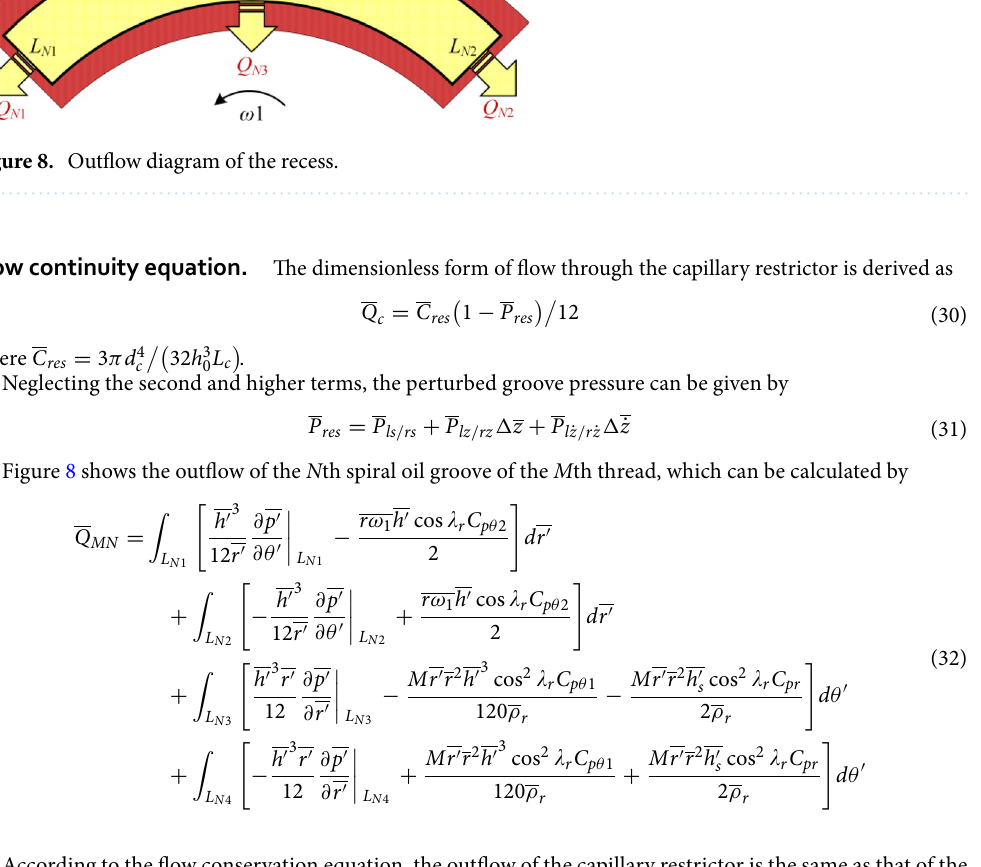
According to the flow conservation equation, the outflow of the capillary restrictor is the same as that of the spiral groove: